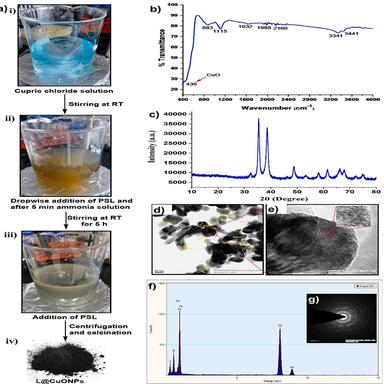
a) (i-iv) Schematic presentation of the synthesis of L@CuONPs; Characterization of L@CuONPs; b) FTIR spectra c) XRD analysis; d) HR-TEM images (scale bar 50 nm); e) HR-TEM images (scale bar 2 nm); f) EDX analysis; and g) SAED pattern.